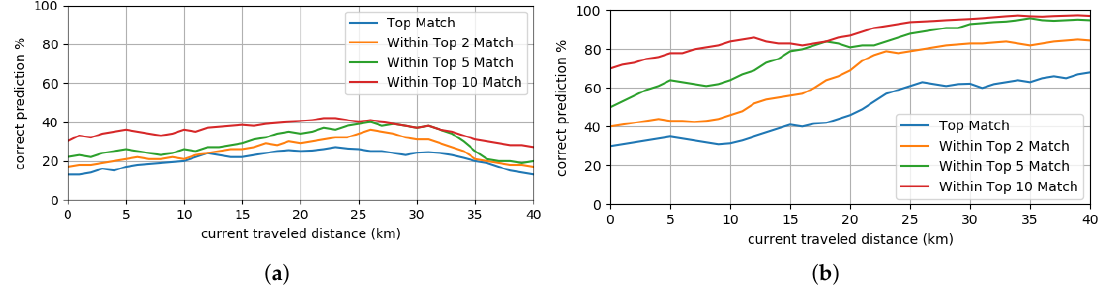
Figure 14. Performance of the MPP algorithm across different trips. ( a ) Driving on new routes. ( b ) Driving repetitively on the same